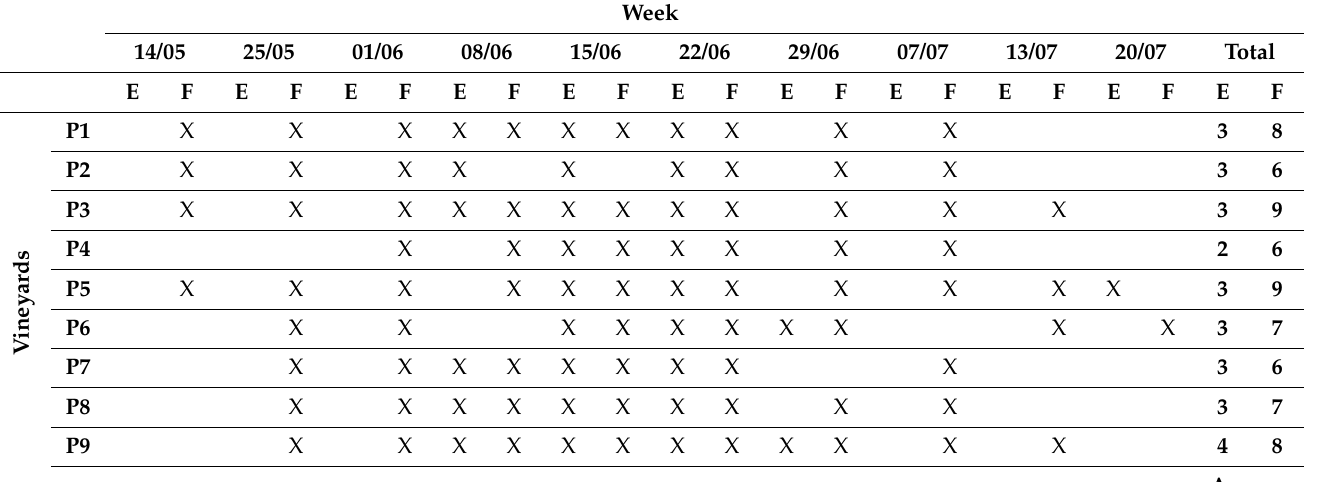
Table 2. Dates of spray applications and total number of treatments performed for powdery mildew control in EPI (E) and farmer (F) plots of the nine studied vineyards during 2020. Different letters indicate significant differences among samples ( p < 0.05).